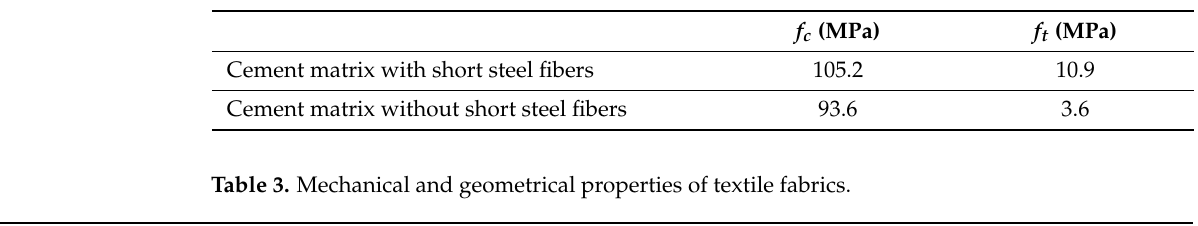
Table 2. Mechanical properties of the cementitious matrices.